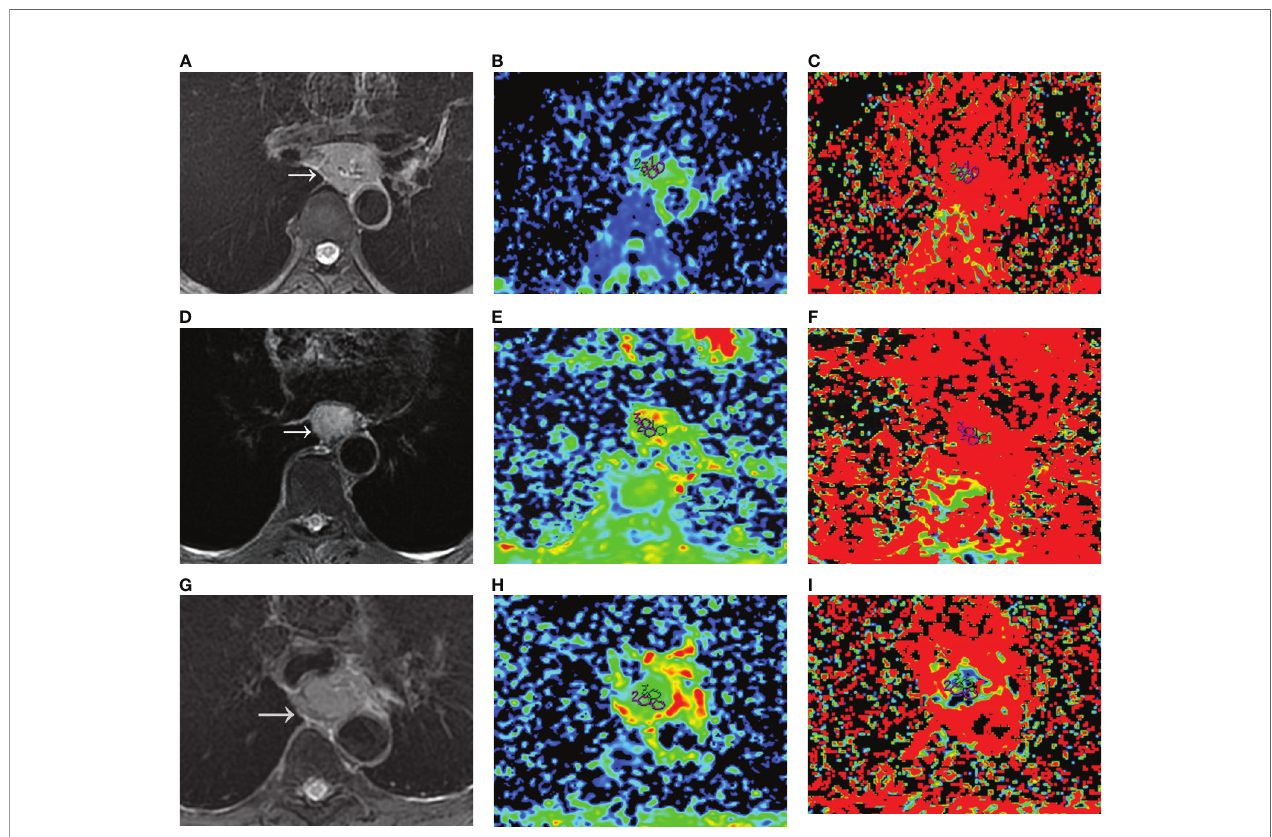
FIGURE 1 | D mono and f mono values derived from mono-exponential IVIM-DWI of ESCC with different pathologically differentiated grades. (A – C) PD ESCC in a 48-year-old man. The regions of interest are selected by (A) T2-weighted image and drawn on (B) D mono map (0.958×10 -3 mm 2 /s) and (C) f mono map (0.381×100%). (D – F) MD ESCC in a 64-year-old man. The regions of interest are selected by (D) T2-weighted image and drawn on (E) D mono map (1.450×10 -3 mm 2 /s) and (F) f mono map (0.290×100%). (G – I) WD ESCC in a 61-year-old man. The regions of interest are selected by (G) T2-weighted image and drawn on (H) D mono map (1.54×10 -3 mm 2 /s) and (I) f mono map (0.120×100%). IVIM, intravoxel incoherent motion; DWI, diffusion-weighted imaging; ESCC, esophageal squamous cell carcinoma; PD, poorly-differentiated; MD, moderately-differentiated; WD, well-differentiated; D, true diffusion coef fi cient; f, pseudo diffusion